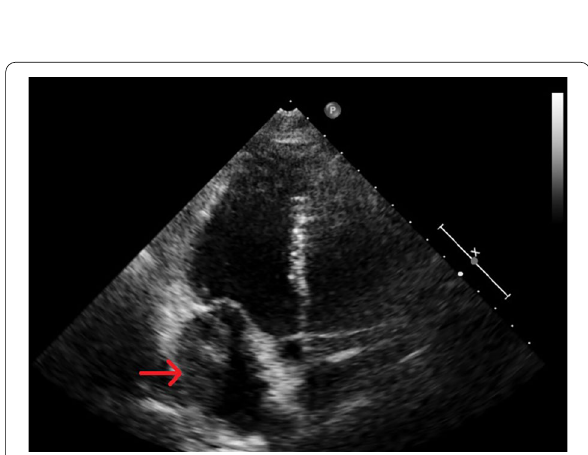
Fig. 2 Transthoracic echocardiogram in apical four-chamber view shows well-circumscribed hypoechogenic mass in the lateral wall of the left atrium